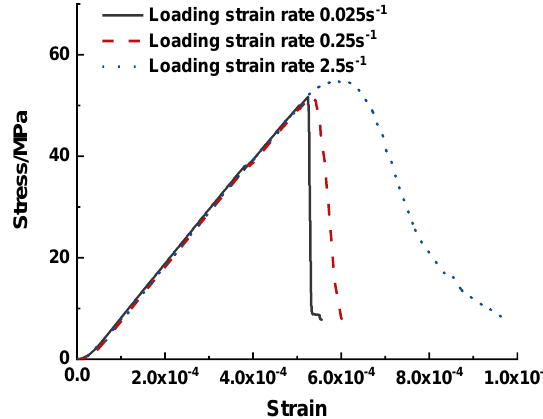
Table 3. Cold crushing strengths and fracture energies of the cases with varying loading strain rates. Figure 7. Stress–strain curves of cases with varying loading strain Figure 7. Stress – strain curves of cases with varying loading strain rates.